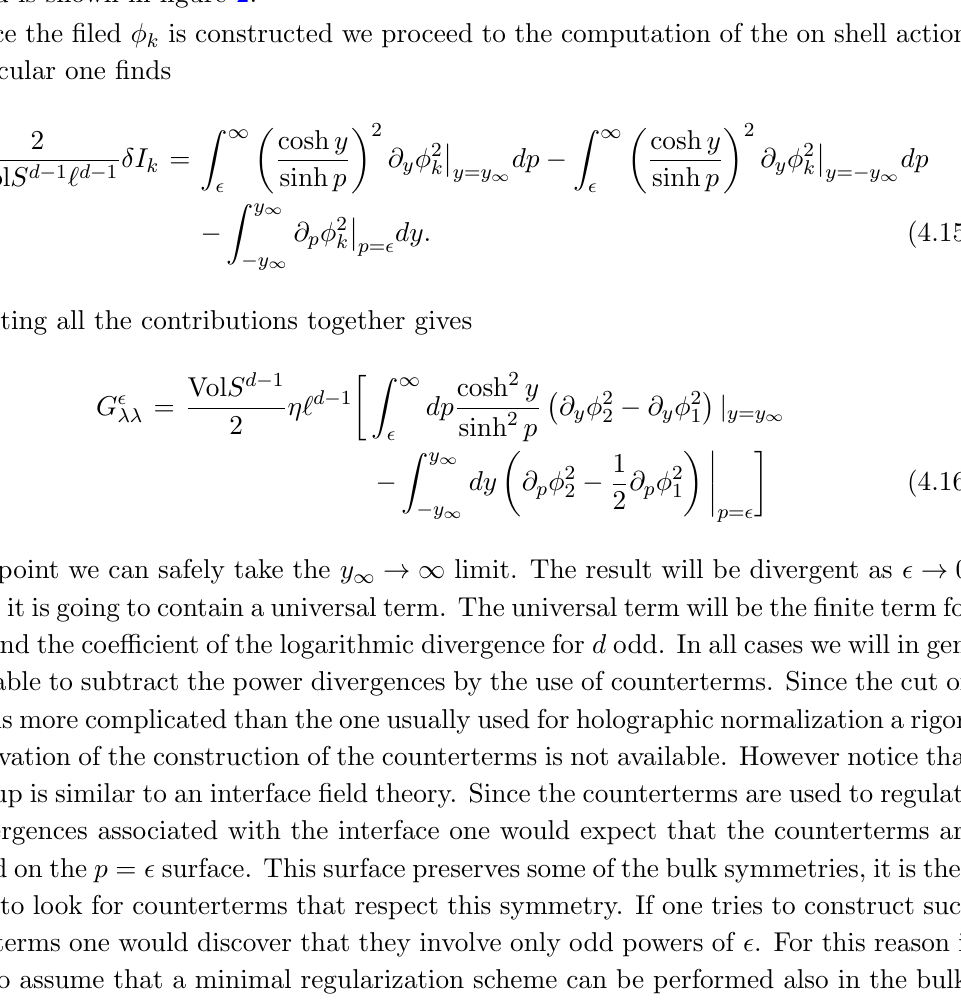
( y ; y ) and p ( (cid:15); 2 (cid:0) 2 1 1 1